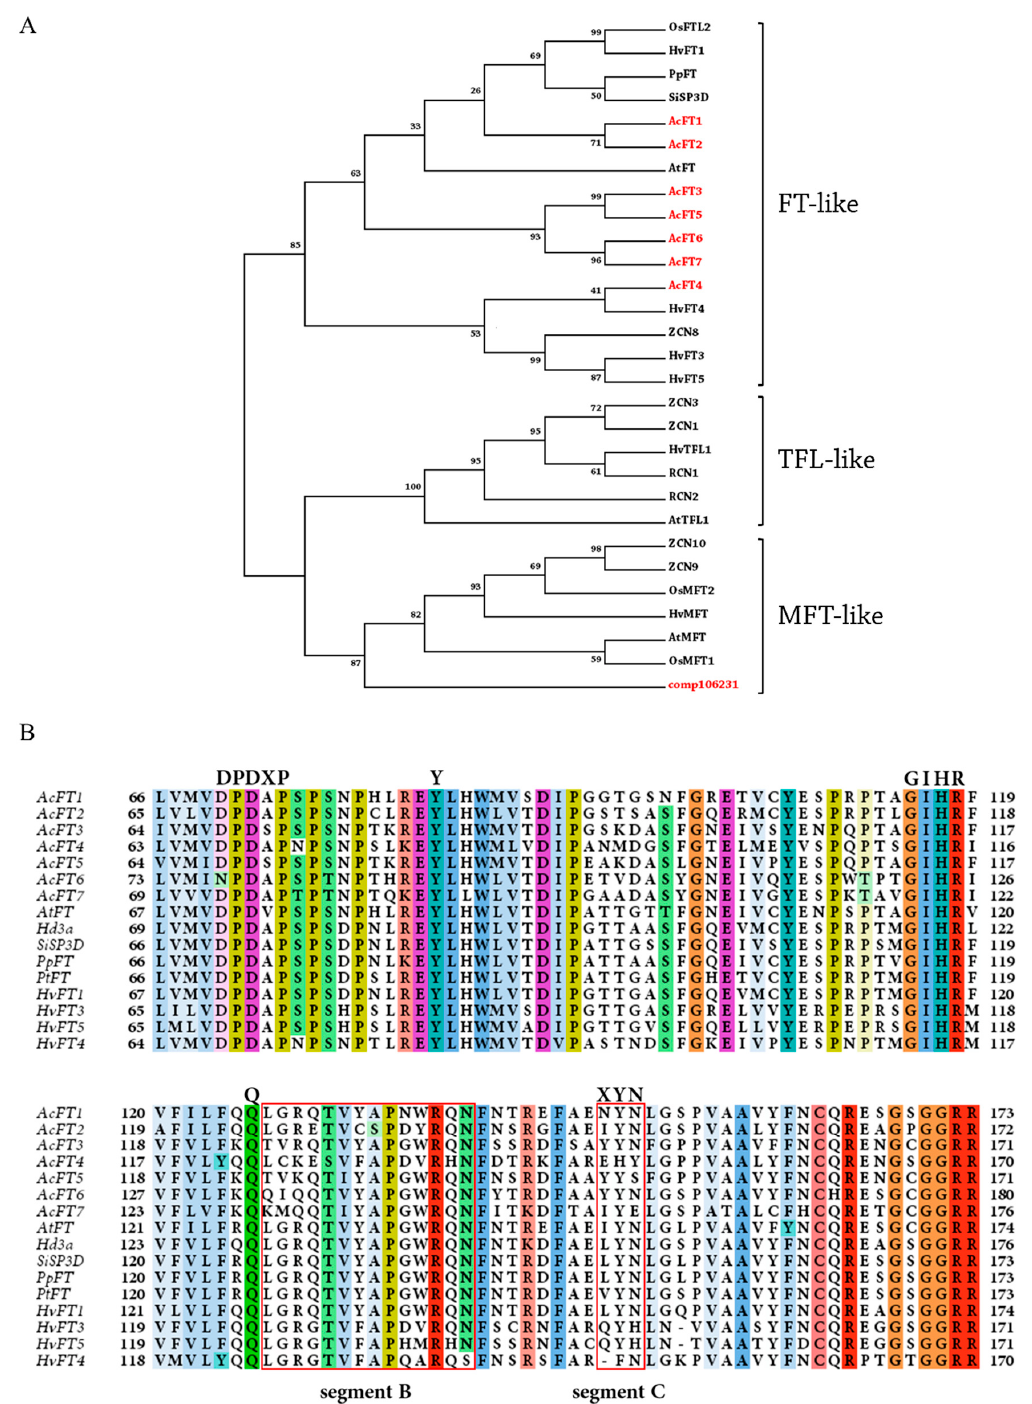
Figure 1. ( A ) Phylogenetic analysis of members of PEBP family from rice, barley, peach, maize, and Arabidopsis . Sequences were aligned using ClustalW, and tree was constructed using Maximum likelihood (ML) method employing JTT matrix along with 1000 bootstrap replication. The bootstrap value at the tree nodes represent robustness of the tree. Red color highlighted genes represent identified FT proteins in Allium cepa ; ( B ) Alignment of the deduced protein sequence of AcFT, identical residues are shaded with different colors. Solid red boxes represent Segment B (14-amino acid length) and C (XYN triad), respectively, and capitalized letters above the alignment represent functionally important conserved residues of FT proteins.